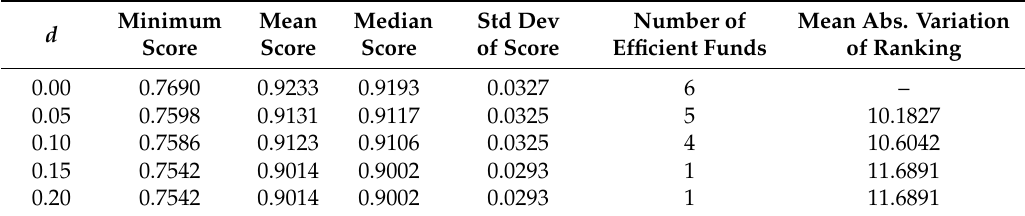
Table 4. Main results for the VW restrictions with constraints on all DMUs in the case of asymmetric bounds and T = 1. Summary statistics on the performance scores (minimum, mean and median values, standard deviation), number of efficient funds and mean absolute variation (divided by 2) of the ranking positions.